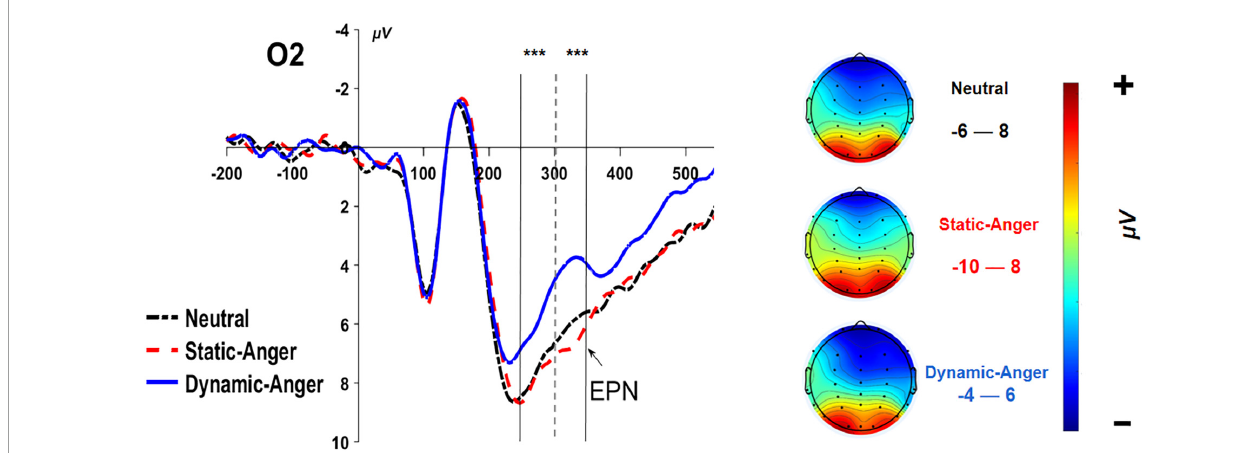
FIGURE5 The grand-mean ERP waveforms of the EPN component at O2. *** P < 0.001.